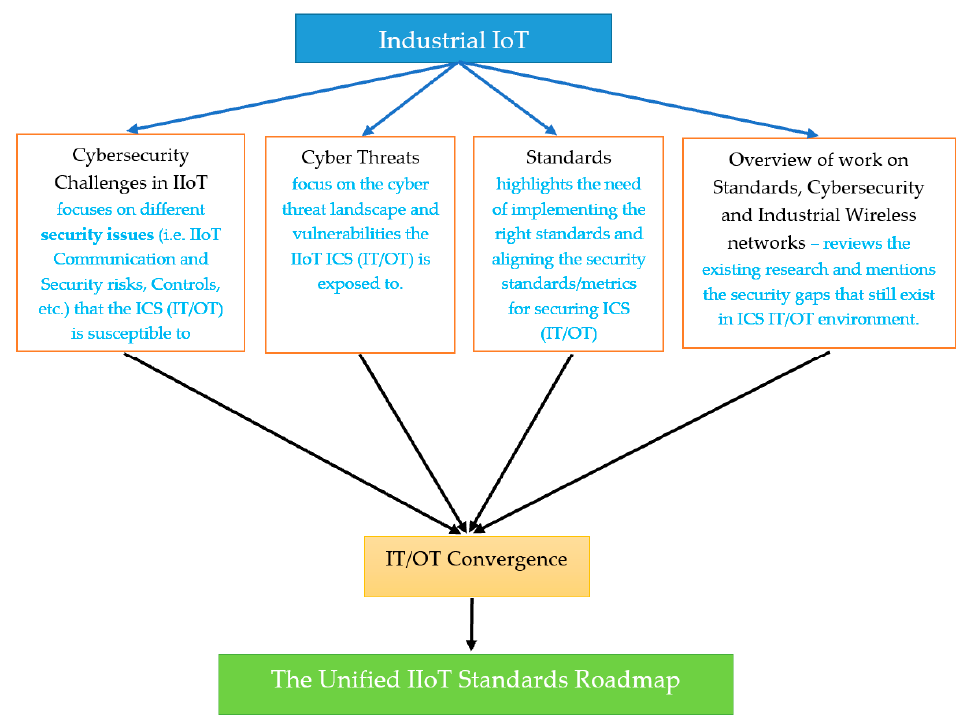
Figure 1. Rationale. Figure 1.